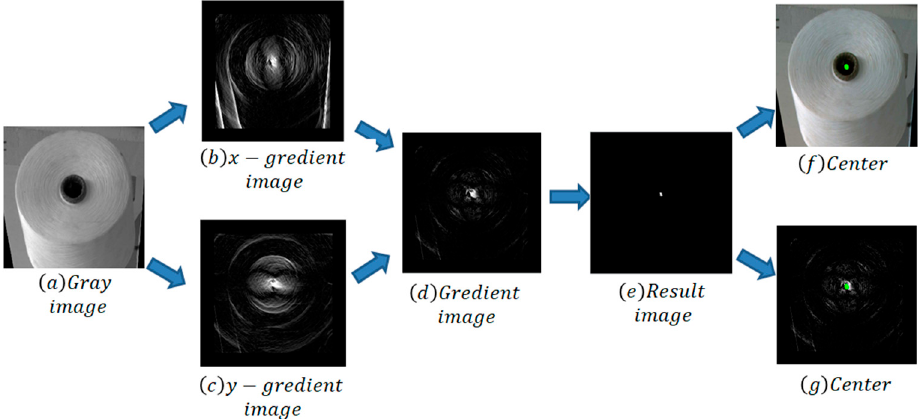
Figure 7. Circle filters.